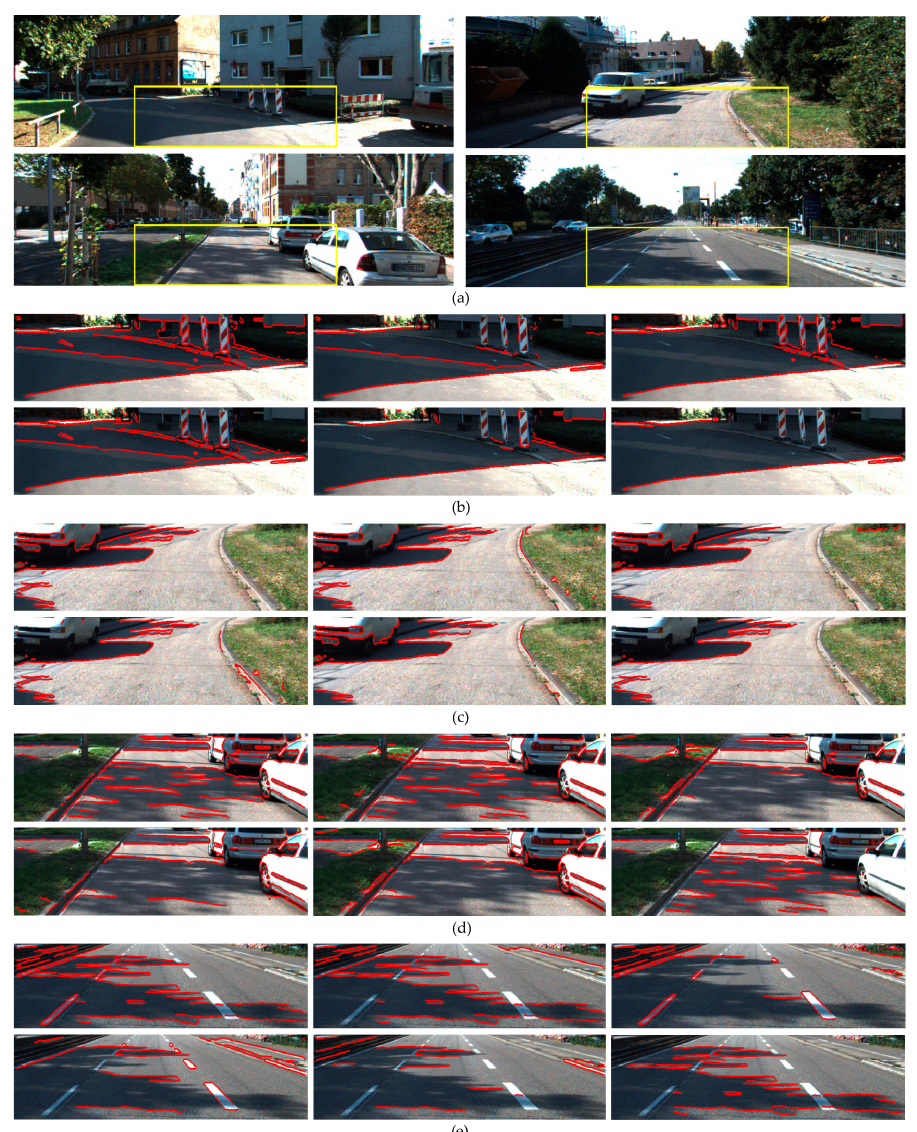
Figure 21. Shadow edge detection results obtained using the five methods. ( a ) ROI overlaid onto incoming images. ( b – e ) Top-left results of Method 1; top-center results of Method 2; top-right results of Method 3; bottom-left results of Method 4; bottom-center results of Method 5; bottom-right results of our